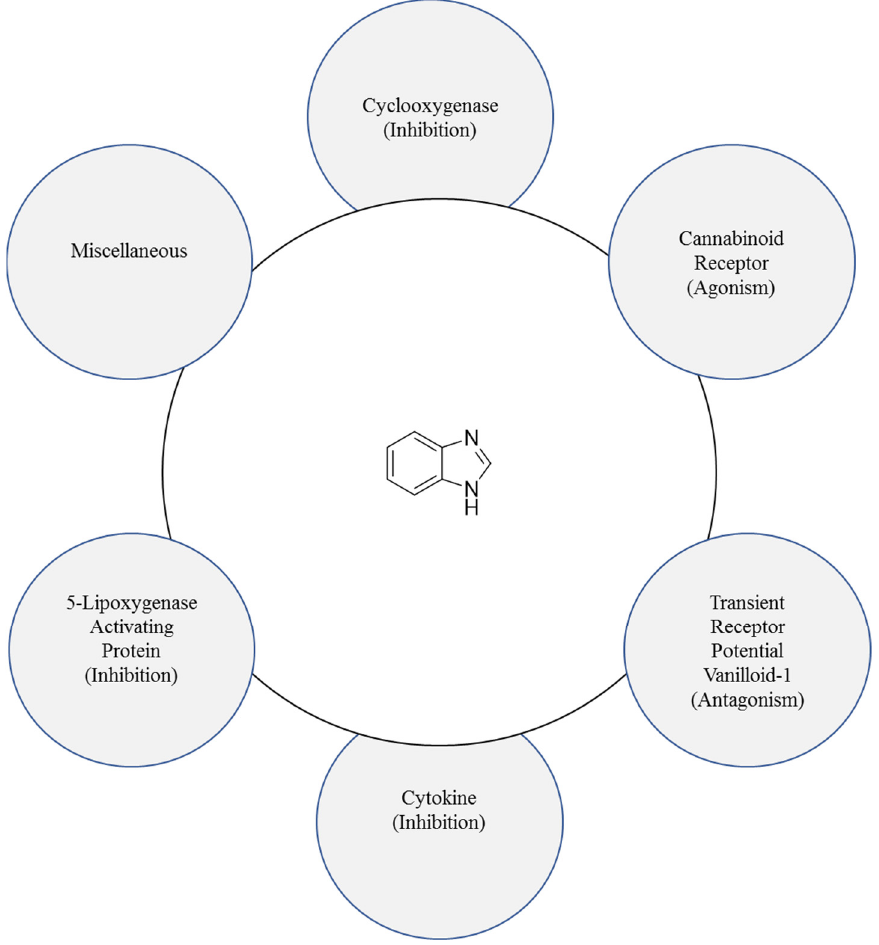
Figure 5. Benzimidazole’s interactions with clinically approved targets.